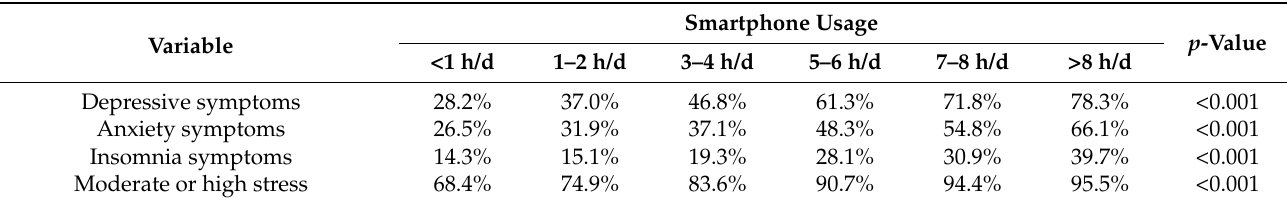
Table 3. Proportion of participants exceeding the cut-off scores for moderate depressive, anxiety, insomnia, and stress symptoms by smartphone